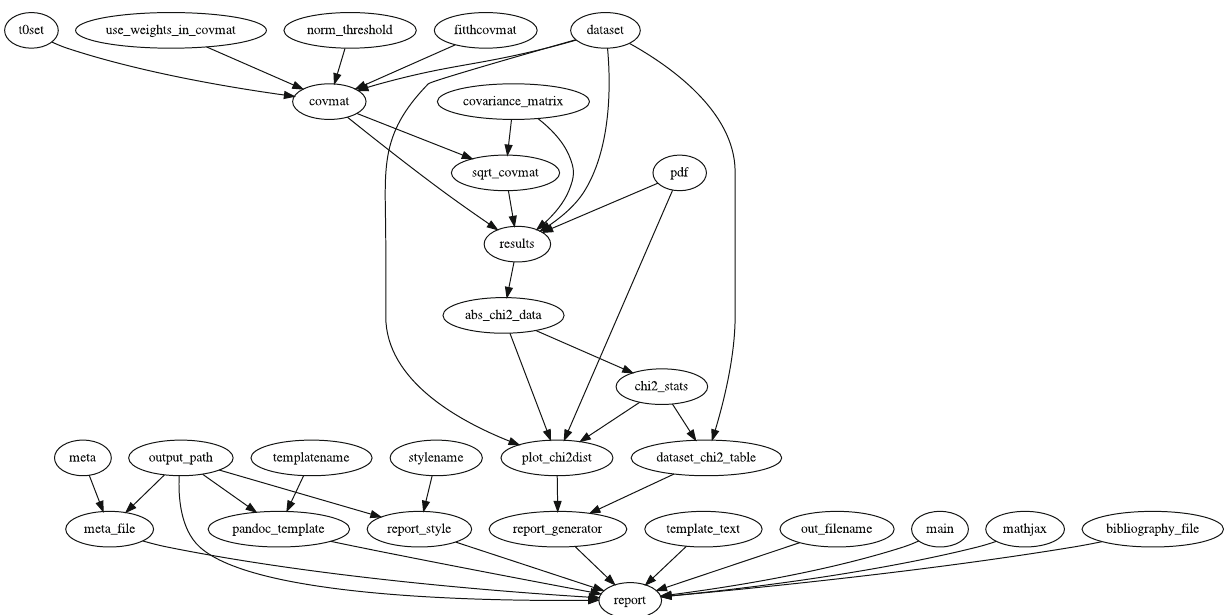
Fig. 2 Direct acyclic graph corresponding to the run card provided in Fig. 3. The graph shows the inputs extracted from the run card, such as pdf (thePDFset)andthe dataset ,theintermediatestepsrequiredfor the χ 2 computation (such as evaluating the covariance_matrix ),